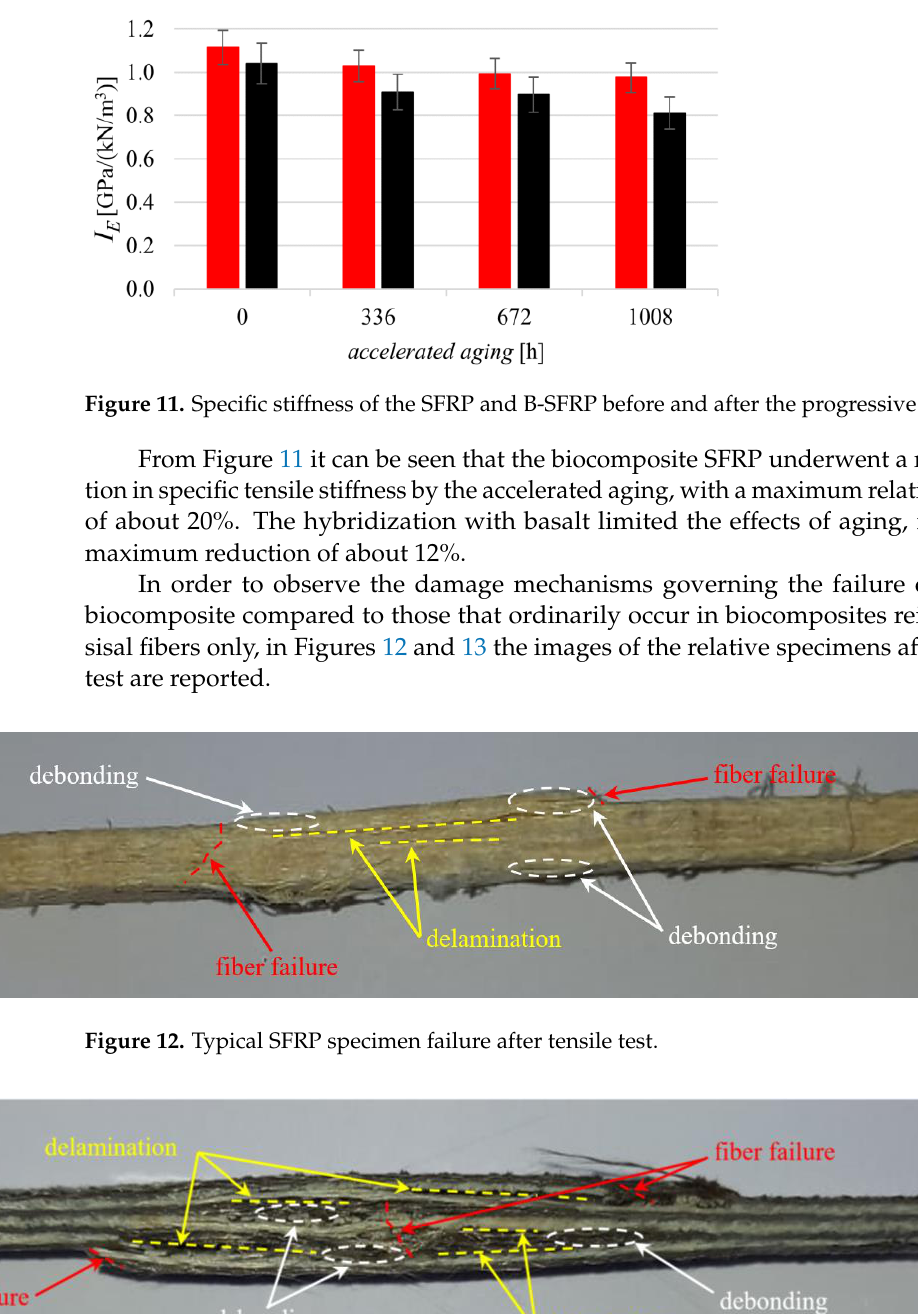
Figure 10. Specific strength of the SFRP and B-SFRP before and after the progressive aging.